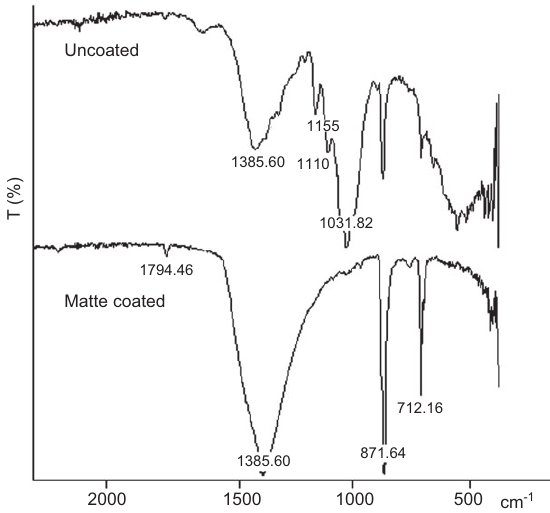
Figure 2 ATR spectrums of uncoated and matte-coated paper surfaces.